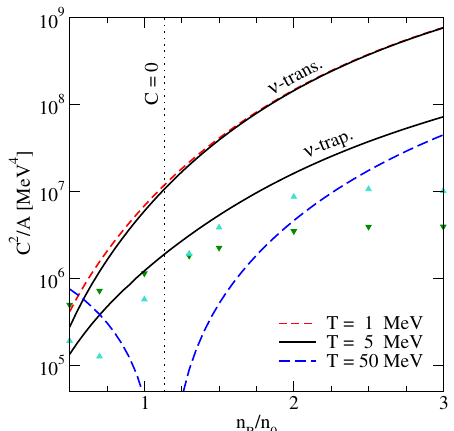
Figure 2. The susceptibility prefactor C 2 / A as a function of the baryon density for three values of the temperature for the neutrino-transparent matter (upper curves labelled as ν -trans.) and neutrino-trapped matter (lower curves labelled as ν -trap.). The upper and lower triangles show the results of reference [6] for models IUFSU and DD2, respectively.